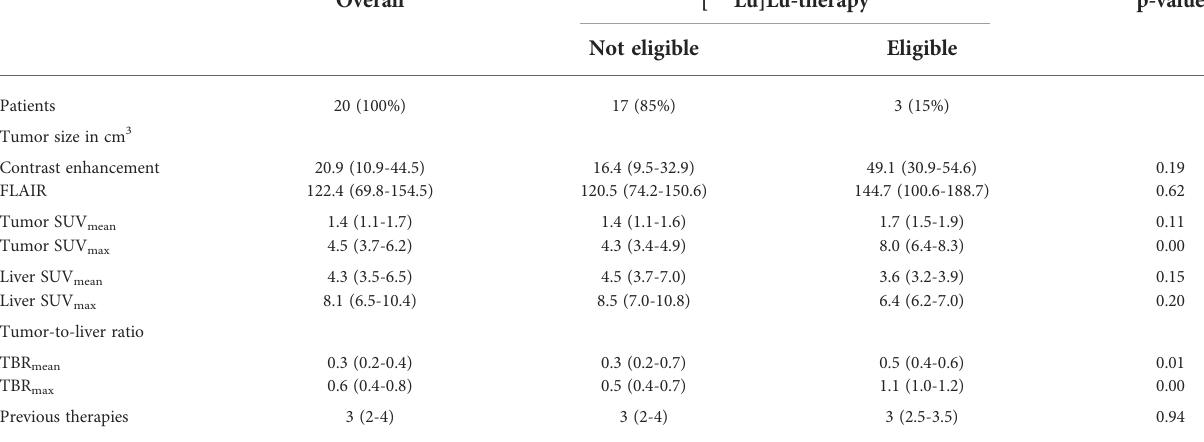
TABLE 2 SUV and TBR in [ 68 Ga]Ga-PSMA PET/MRI.